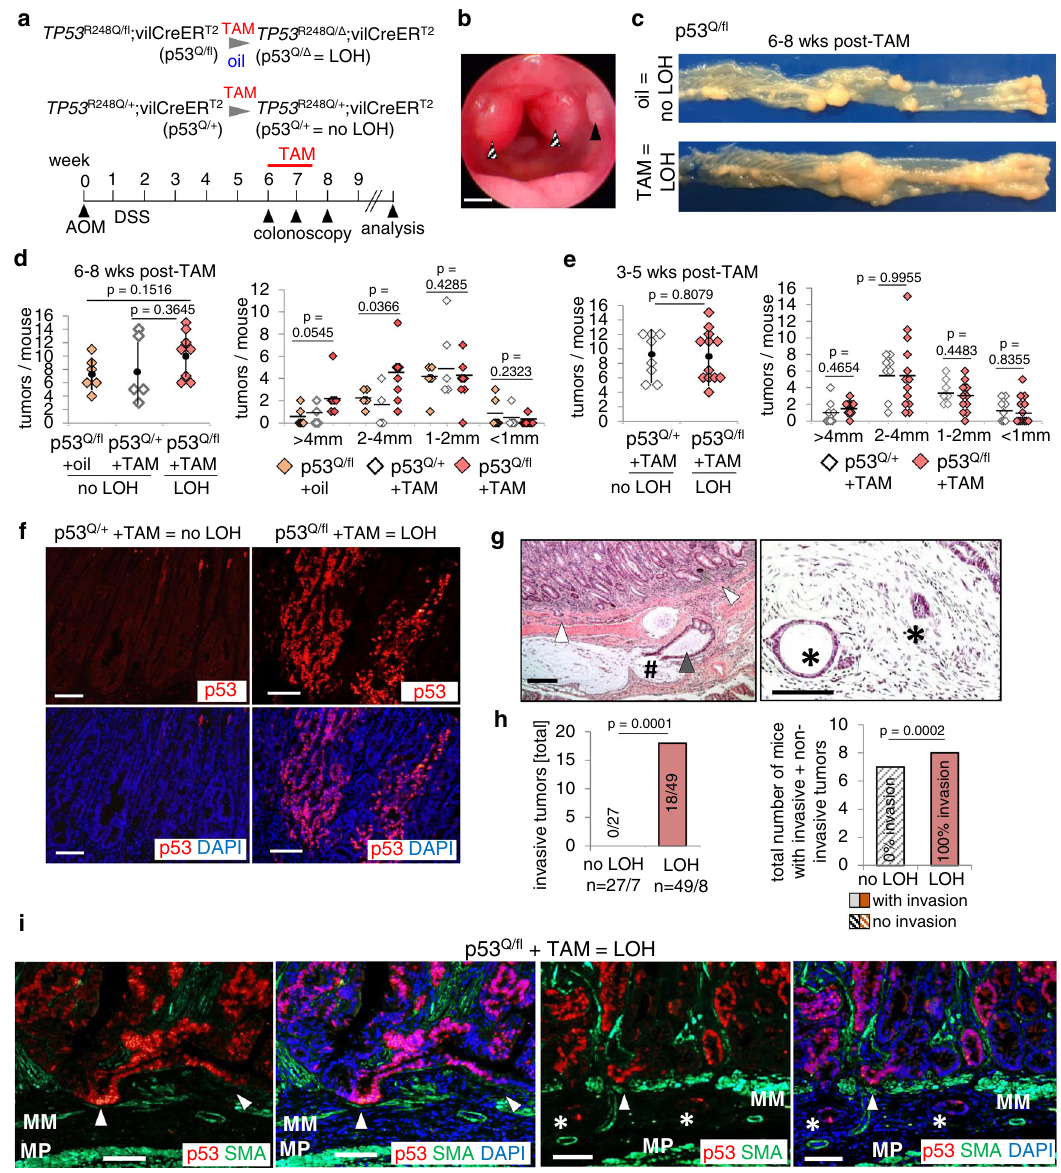
Fig. 1 p53LOH is a prerequisite for mutp53 stabilization and enables invasion in CRC. a p53LOH induction scheme in intestinal epithelial cells. The GOF TP53 R248Q allele ( “ p53 Q ” ) is paired with the conditional wild-type Trp53 allele (p53 fl ). A constitutive WTp53 allele ( “ p53 + ” ) serves as control. Colorectal tumors were initiated with AOM/DSS. At a de fi ned tumor burden visualized by colonoscopy TAM (Tamoxifen) or oil treatment was administered. Oil- treated p53 Q/ fl ;vilCreER T2 and TAM-treated p53 Q/ + ;vilCreER T2 control mice carry heterozygous tumors (no LOH), whereas TAM-treated TP53 R248Q/ fl ; vilCreER T2 (p53 Q/ Δ ) mice carry p53LOH tumors. Mice were analyzed 2 – 8 weeks after LOH induction. b Representative colonoscopy of an untreated TP53 R248Q/ fl ;vilCreER T2 mouse 8 weeks post AOM. Tumors with scores S2 (solid arrow) and S3 (dashed arrows) 79 . Scale bar, 1 mm. c Representative view of dissected colons of p53 Q/ fl mice 6 weeks after p53LOH induction. Left, ileocecal valve; right, anus. d Number of tumors per mouse (left) and tumor sizes (right) 6 – 8 weeks post TAM or oil treatment. Both “ no LOH ” groups had the same tumor burden. p53 Q/ fl + oil, n = 6; p53 Q/ + + TAM, n = 5; p53 Q/ fl + TAM, n = 8. e Number of tumors per mouse (left) and tumor sizes (right) analyzed at 3 – 5 weeks post TAM. p53 Q/ + + TAM, n = 8; p53 Q/ fl + TAM, n = 13. f Representative immuno fl uorescence of p53 for TAM-treated p53 Q/ + and TAM-treated p53 Q/ fl mice at endpoint 6 weeks post TAM. Scale bars, 100 μ m. g Representative H&E of two LOH p53 Q/ fl tumors 8 weeks after TAM. Left, extensive invasion within muscularis propria and muscularis mucosae (white arrows). One malignant gland (black arrow) is ruptured, spilling its content into mucous lakes with single tumor cells fl oating (#). Right, invading glands in submucosa (*). Scale bars, 100 µ m. h (Left) total numbers of invasive tumors and (right) total numbers of mice with noninvasive and invasive tumors in the “ no LOH ” group (combined from oil-treated p53 Q/ fl and TAM-treated p53 Q/ + mice) versus the “ LOH ” group (p53 Q/ Δ , TAM-treated p53 Q/ fl mice) analyzed at 6 – 8 weeks post oil/TAM. (Left) “ no LOH ” , n = 27 total tumors from seven mice and “ LOH ” , n = 49 total tumors from eight mice. (Right) “ no LOH ” n = 7 mice and “ LOH ” n = 8 mice. Both Fisher ’ s exact tests. (Left) noninvasive tumors were included in the statistical calculation. Bars, mean. i Stabilized mutp53 at the invasive front. Two tumors from different LOH mice 6 weeks post TAM. Representative immuno fl uorescence, p53 (red), α -SMA (green), and DAPI (blue). MM muscularis mucosae, MP muscularis propria. White arrows, tumor cells invading the MM. Asterix, small invasive cell clumps invading submucosa. Scale bars, 100 μ m. d , e (Left) dots with vertical black lines represent means ± SD. (Right) horizontal black lines indicate means. Student ’ s t test,